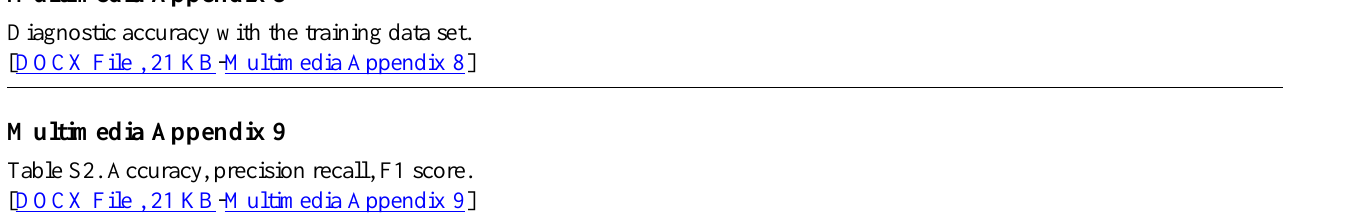
Table S2. Accuracy, precision recall, F1